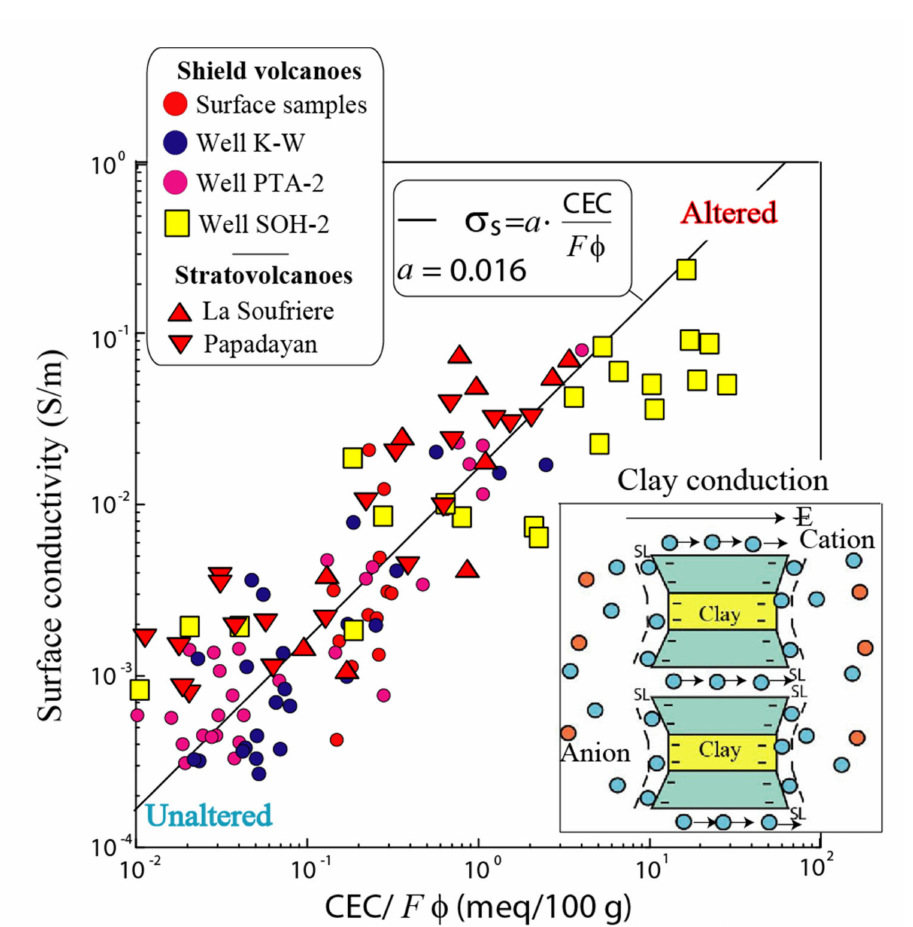
Figure 5. Relationship between surface conductivity σ S (S m − 1 ) versus the reduced (or normal- ized) CEC defined as CEC /F φ where CEC denotes the cation exchange capacity (expressed here in meq/100 g), F the formation factor, and φ the connected porosity (1 meq/(100 g) = 963.2 C kg − 1 ) (Modified from Revil et al. [52]). The slope is equal to B ρ g . Keeping in mind that the CEC is here expressed in meq/100 g, using B (Na + , 25 ◦ C) = 3.1 × 10 − 9 m − 2 s − 1 V − 1 (mobility of the cations along the mineral surface) and ρ g = 2900 kg m − 3 , yield, a = 0.009 close to the observed trend a = 0.016 ± 0.08. The datasets show that the trend is unique for both stratovolcanoes and shield volcanoes. E denotes the electrical field, SL denotes the Stern Layer. The cations are in blue and the anions in